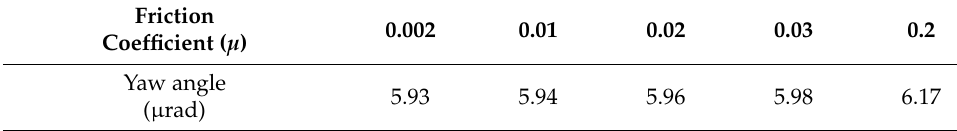
Table 4. Convergence value of yaw angle according to friction